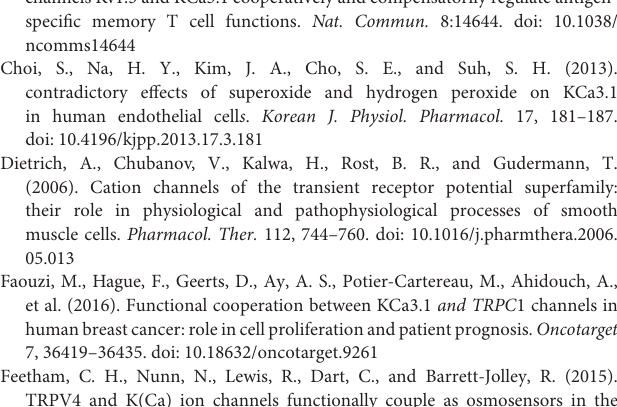
FIGURE S1 | TRPV4 involved in Ca 2 + entry induced by KCa3.1 activation in asthmatic HBSM cells. (A,B) Representative curves showed the fluorescence intensity in [Ca 2 + ] i over 360 s. (A) External calcium was required for 200 µ M 1-EBIO-induced Ca 2 + elevations. The increase of [Ca 2 + ] i induced by 200 µ M 1-EBIO was prevented by 0 external Ca 2 + . (B) Representative traces of 1-EBIO-induced Ca 2 + entry in the HBSM cells transfected with siKCa3.1, siTRPV4 or siCtrl. 1-EBIO was used at 200 µ M. Ctrl: control. FIGURE S2 | 1-EBIO induced Ca 2 + entry with or without external K + in asthmatic HBSM cells. (A,B) Representative curves showed the fluorescence intensity in [Ca 2 + ] i over 360 s. (A) 200 µ M 1-EBIO-induced Ca 2 + elevations. (B) The increase of [Ca 2 + ] i induced by 200 µ M 1-EBIO was prevented by pretreatment of 40 mM external K + . FIGURE S3 | The gene expressions of REST and AP-1 were correlated negatively or positively with the expression of KCa3.1 channels. The gene expressions of REST and AP-1 were correlated negatively or positively with the expression of KCa3.1 channels in chronic asthma. KCa3.1 regulated Ca 2 + influx via functional cooperation with TRPV4 in asthmatic HBSM